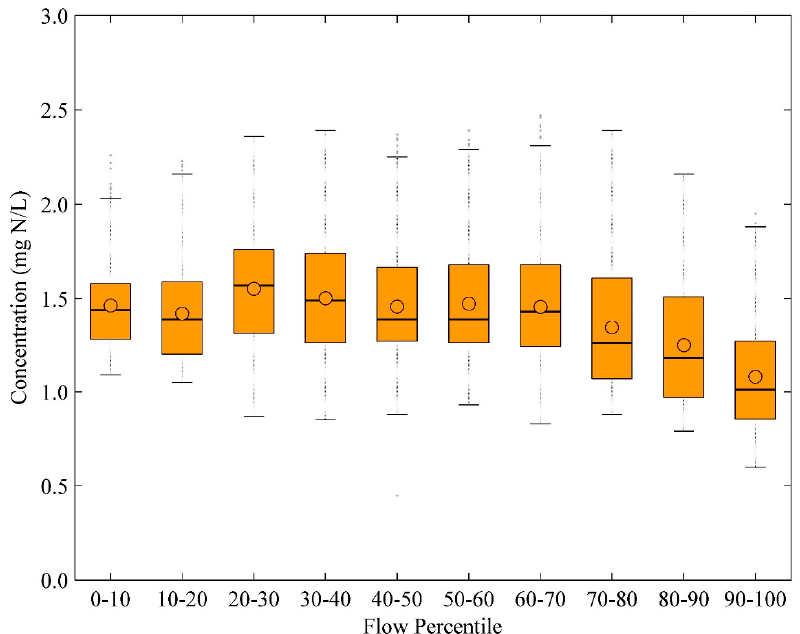
Figure 8. Boxplots of storm nitrate concentration at different flow percentiles for all monitored storm events. The error bars and circles inside the colored boxes represent the median and mean of the data. The lower and upper edges of boxes represent 25th and 75th percentiles. The error bars outside the colored boxes represent the 10th and 90th percentiles, and the dots represent 5th and 95th percentiles.